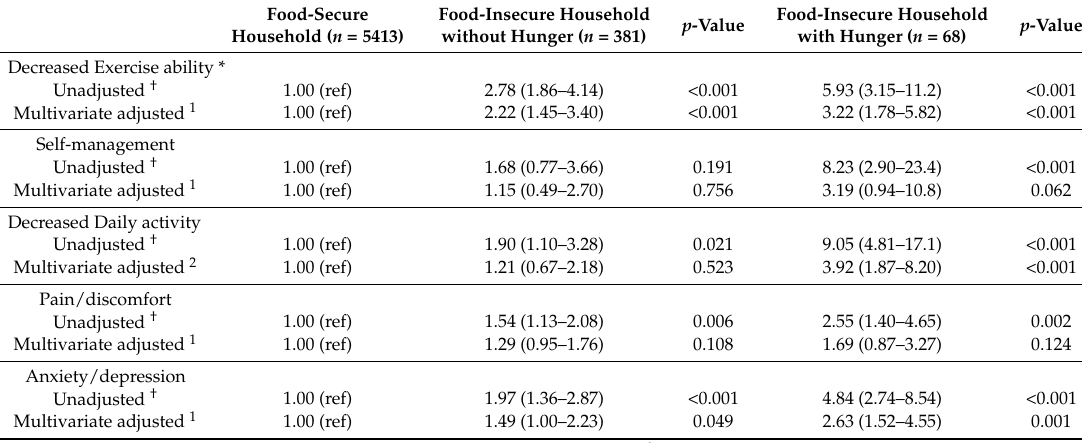
Table 4. Odds ratios and 95% confidence intervals for the quality of life per types of household food